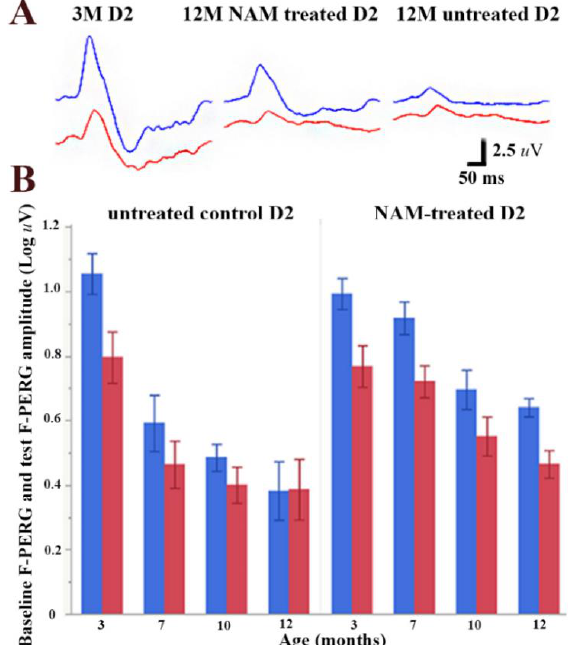
Figure 1. Retinal ganglion cell (RGC) function measurements by pattern electroretinogram (PERG) superimposed with flicker light at 101 or 11 Hz. ( A ) Examples of baseline (blue) and test (red) PERG waveforms recorded D2 mouse at 3 months of age and at 12 months of age with either standard diet or vitamin B3-enriched diet. Note that B3-enriched diet has a protective e ff ect of PERG amplitude; ( B ) Adaptation of F-PERG in D2 mice as a function of age. The amplitude di ff erence between baseline F-PERG and test F-PERG diminished with age in the control group but not in B3-treated group ( n = 10 for each group). Error bars represent the SEM.